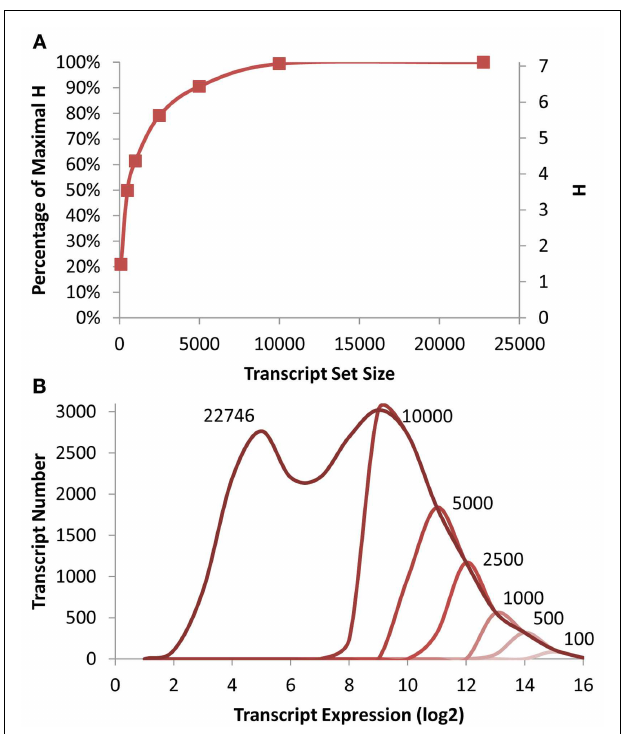
FIGURE 2 | Shannon Entropy estimation of information in eQTL mapping experiments. eQTL mapping with different genetic resolution was modeled and the Shannon entropies were estimated using the previously published Bay x Sha RIL dataset. Diamonds show eQTL mapping with 1cM resolution, squares are 5cM and triangles are 10cM. (A) Shows the estimated Shannon entropy for the different gene set sizes. (B) Shows the fraction of maximal Shannon entropy per gene set size for the same